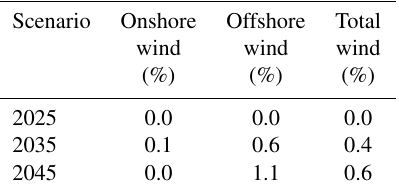
Table 6. VRE curtailments for the scenario with sector coupling. Shares with respect to available